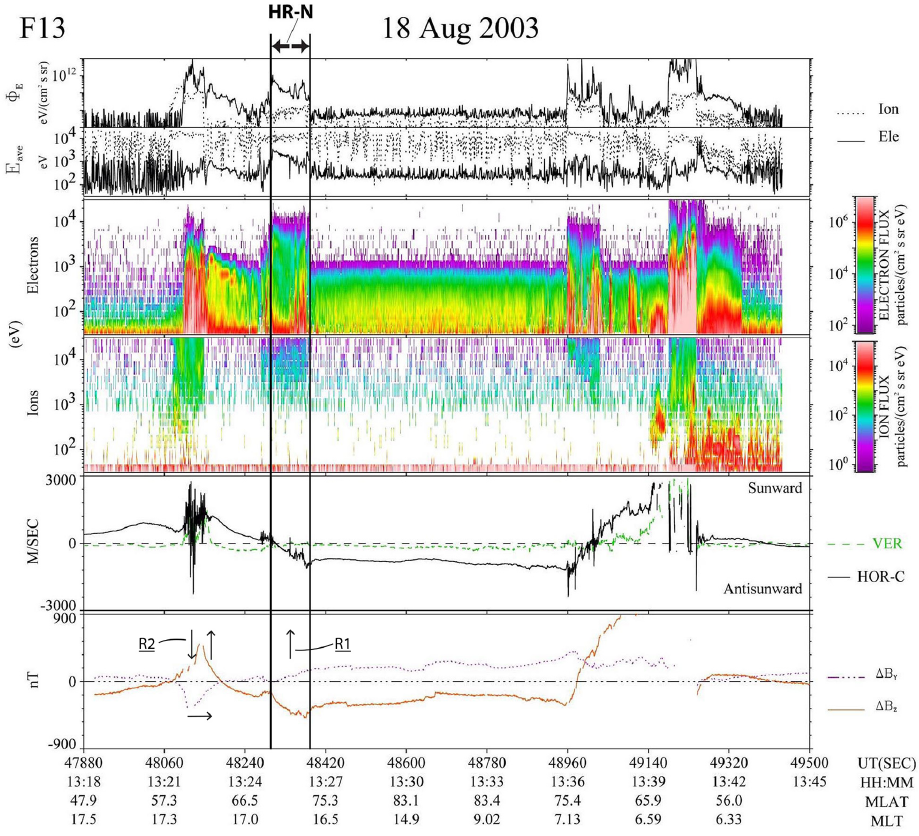
Fig. 5. DMSP F13 data for the dusk-to-dawn traversal of the oval–polar cap – oval during the interval 13:18–13:45UT. Panels from top to bottom shows (i) electron (ion) energy flux, (ii) electron (ion) average energy, (iii) electron spectrograms, (iv) ion spectrograms, (v) cross- track ion drift (horizontal component in black trace), (vi) 1B y and 1B z (yellow). The regime of antisunward convection and northern auroral branch at dusk (Harang region-north; HR-N) is marked by vertical guidelines. Regimes of enhanced FAC intensity are marked by vertical arrows in the bottom